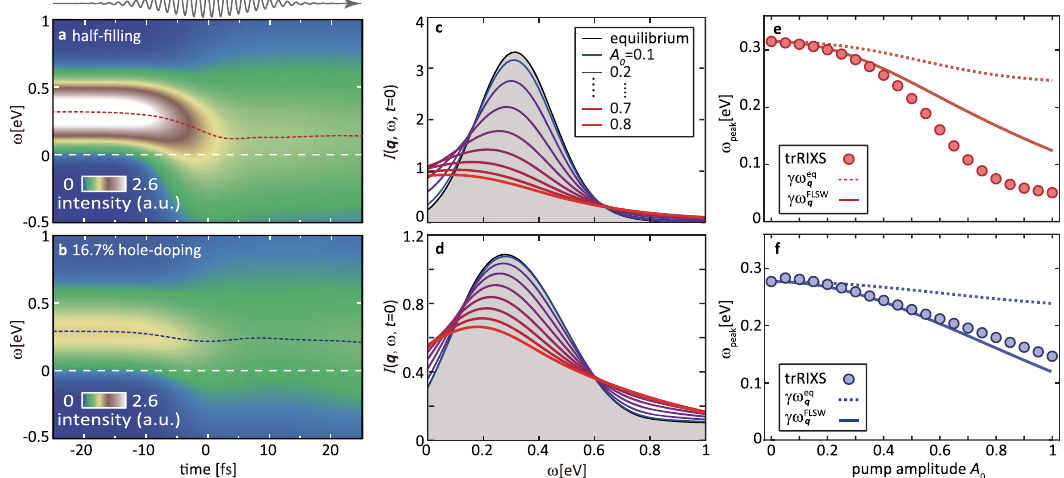
Fig. 3 Time-dependent renormalization of the spin fl uctuations. a , b Time evolution of the cross-polarized time-resolved resonant inelastic X-ray scattering (trRIXS) spectra for pump energy Ω = 10 t h and amplitude A 0 = 0.6 at a x = 0 and b x = 0.167 doping. The momentum transfer is fi xed at q = ( π / 2, π /2). The thin dashed line tracks the instantaneous peak positions of the spin fl uctuation peak. The color bar indicates the spectral intensity in arbitrary units (a.u.). trRIXS spectra at t = 0 (center of the pump pulse) for variable pump amplitudes at c x = 0 and d x = 0.167 doping. Spin excitation energy ω q (the peak of the trRIXS intensity) as function of the pump amplitude at e x = 0 and f x = 0.167 doping. The energy width of these spectra includes a broadening due to the fi nite X-ray probe duration. The dashed line denotes pure photodoping effects ( γω eq , where ω eq is the numerically evaluated magnon q q energy at equilibrium and γ is the instantaneous local moment de fi ned in the text), while the solid line represents a Floquet linear spin-wave prediction of the magnon energies (including photodoping effects) ( γω FLSW q